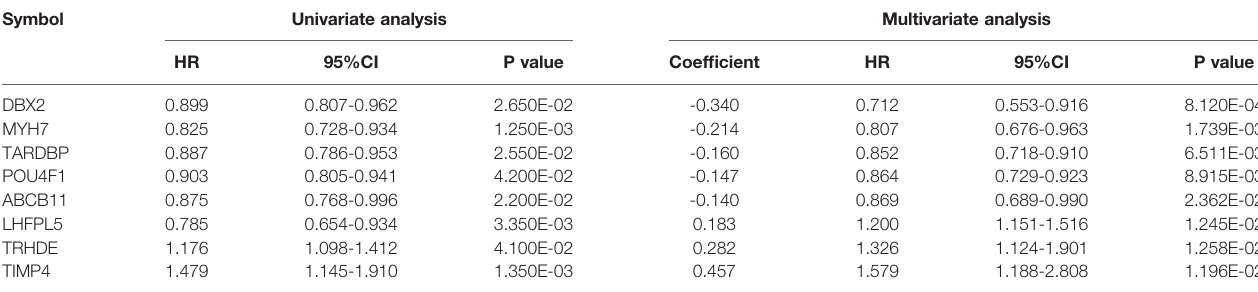
TABLE 2 | Univariate and multivariate analyses of independent prognostic mRNAs. Symbol